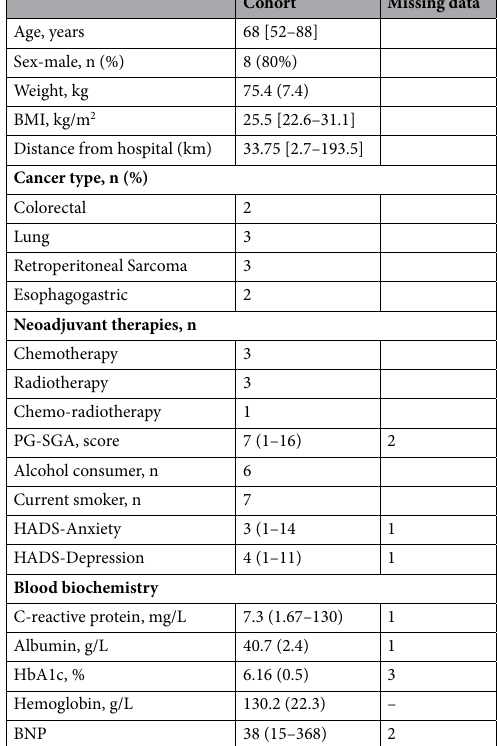
The program: functional and clinical trajectories, success and challenges. Teleprehabilitation